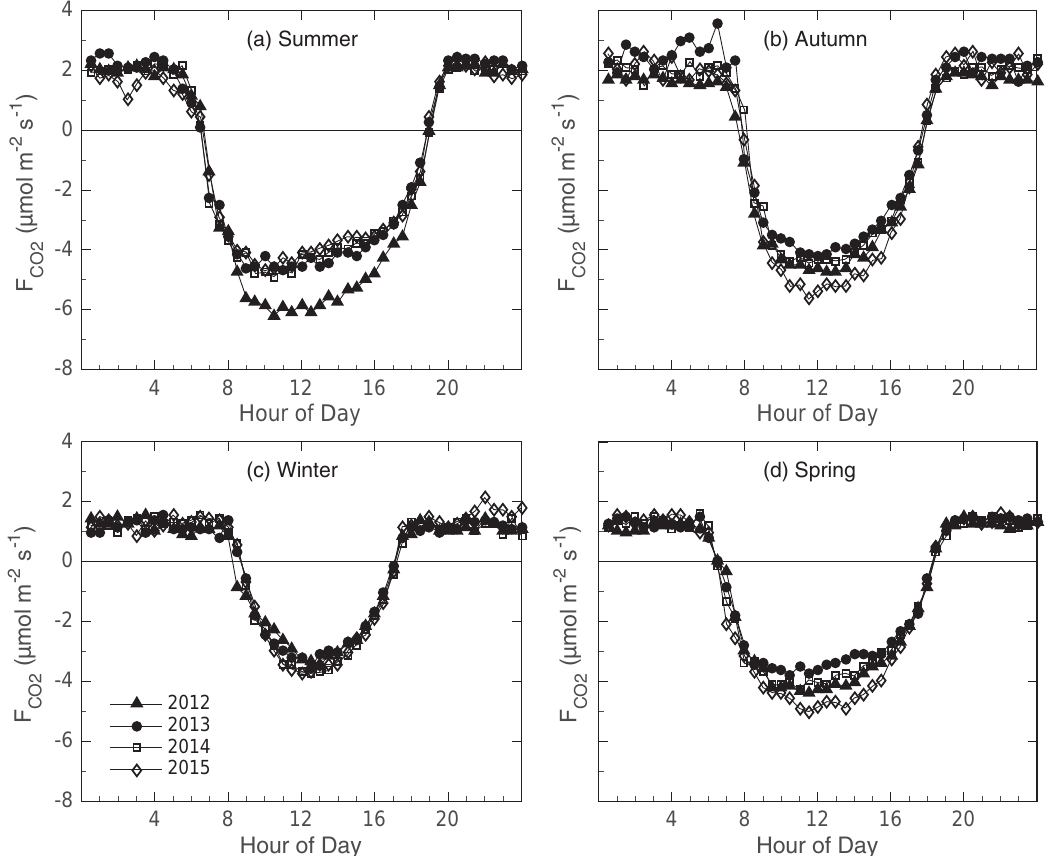
Figure 4. Seasonal ensemble average F CO years.